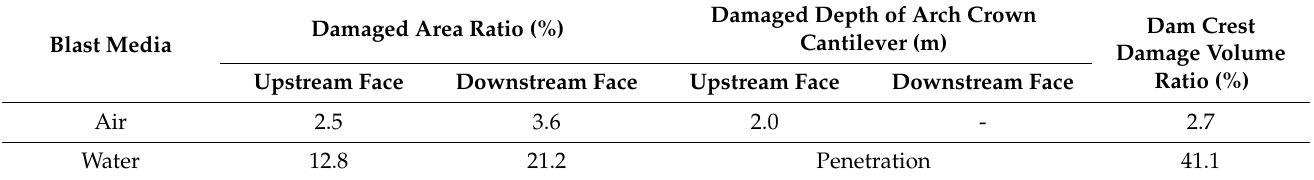
Table 2. Damage of arch dams under various blast